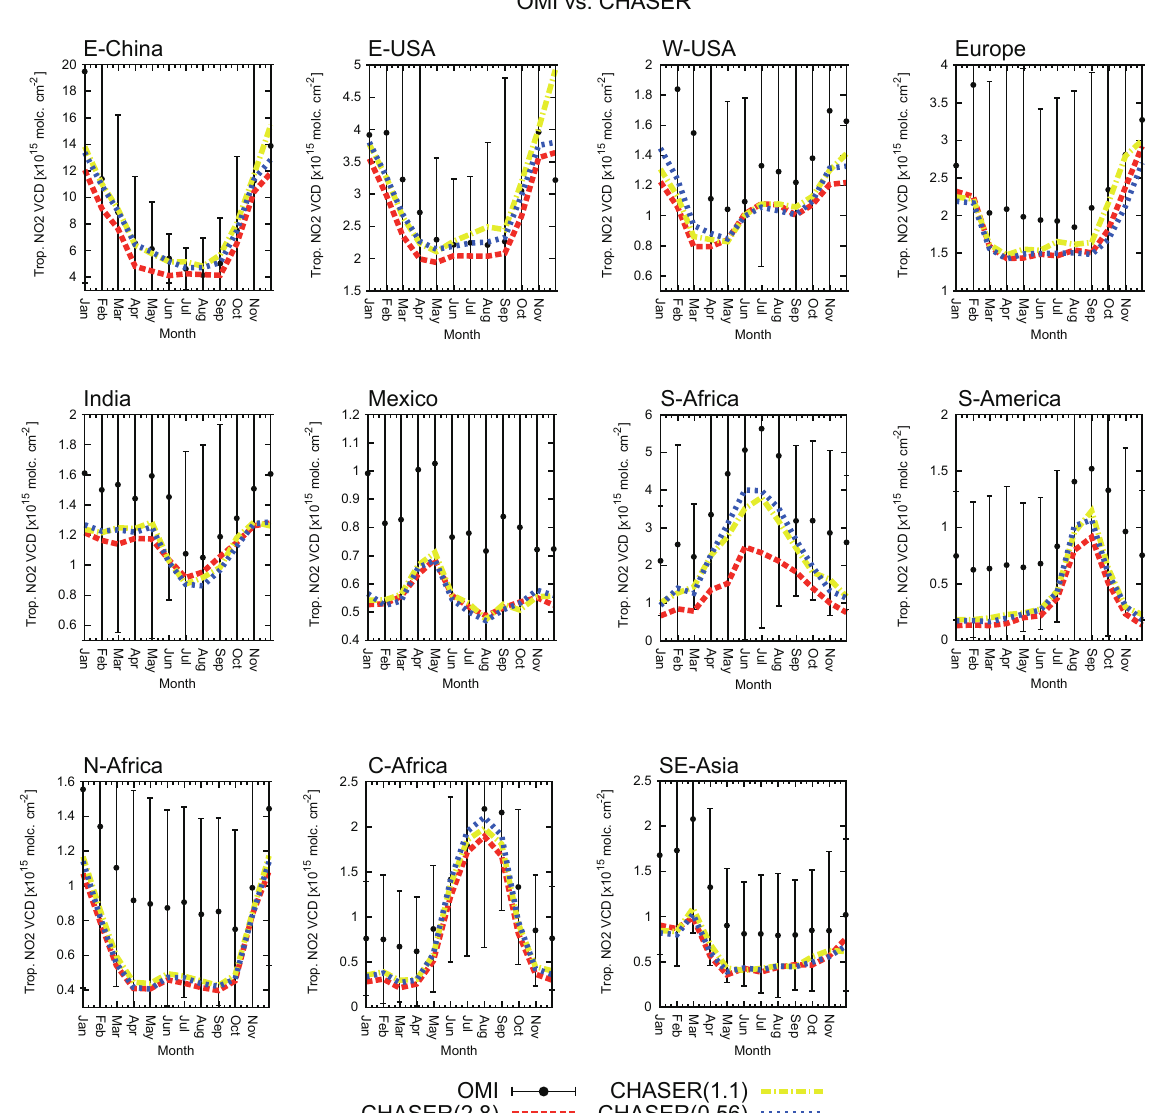
Figure 3. Monthly time series of tropospheric NO 2 column ( × 10 15 moleculescm − 2 ) averaged in E-China (110–123 ◦ E, 30–40 ◦ N), E-USA (95–71 ◦ W, 32–43 ◦ N), W-USA (125–100 ◦ W, 32–43 ◦ N), Europe (10 ◦ W–30 ◦ E, 35–60 ◦ N), India (68–88 ◦ E, 8–35 ◦ N), Mexico (115– 90 ◦ W, 15–25 ◦ N), N-Africa (20 ◦ W–40 ◦ E, 0–20 ◦ N), C-Africa (10–40 ◦ E, 20 ◦ S–0), S-Africa (26–31 ◦ E, 28–23 ◦ S), S-America (70–50 ◦ W, 20 ◦ S–0), and SE-Asia (96–105 ◦ E, 10–20 ◦ N). The black dots are OMI retrievals, the red dashed line is the model simulation at 2.8 ◦ resolution, the yellow dashed-dotted line is the model simulation at 1.1 ◦ resolution, and the blue dotted line is the model simulation at 0.56 ◦ resolution. The vertical bars indicate mean OMI retrieval